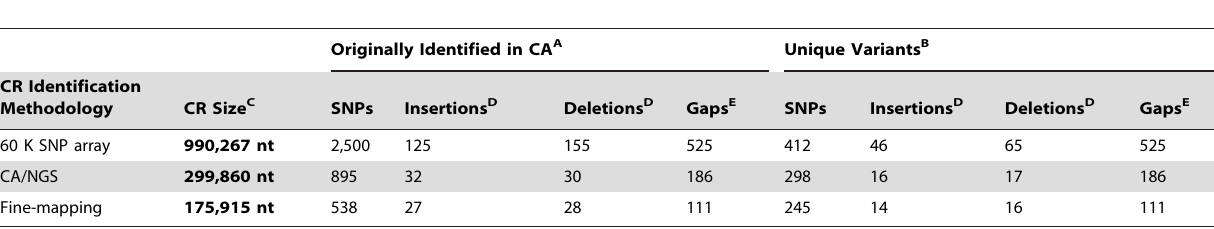
Table 2. Coloboma.003 SNPs, micro-indels, and sequence gaps identified in the various linked regions using CA/NGS technology: Number and genomic